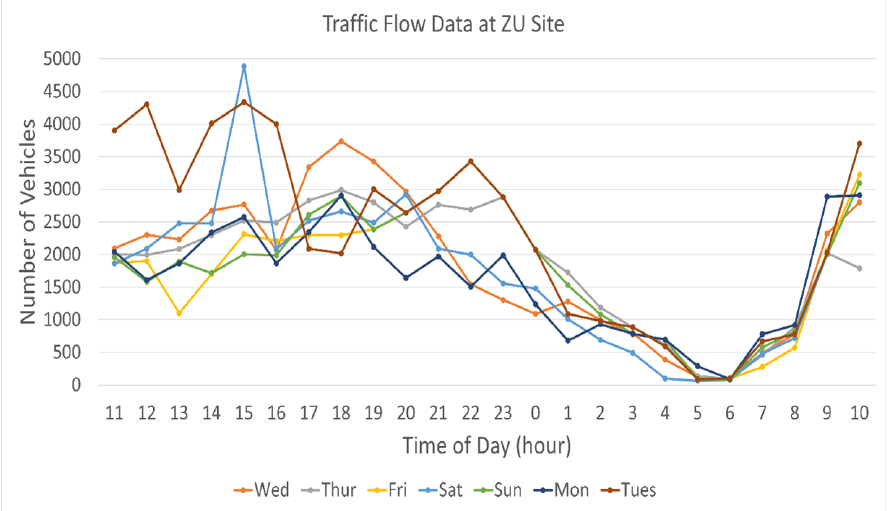
Figure 11. Weekly vehicle statistics collected at the ZU